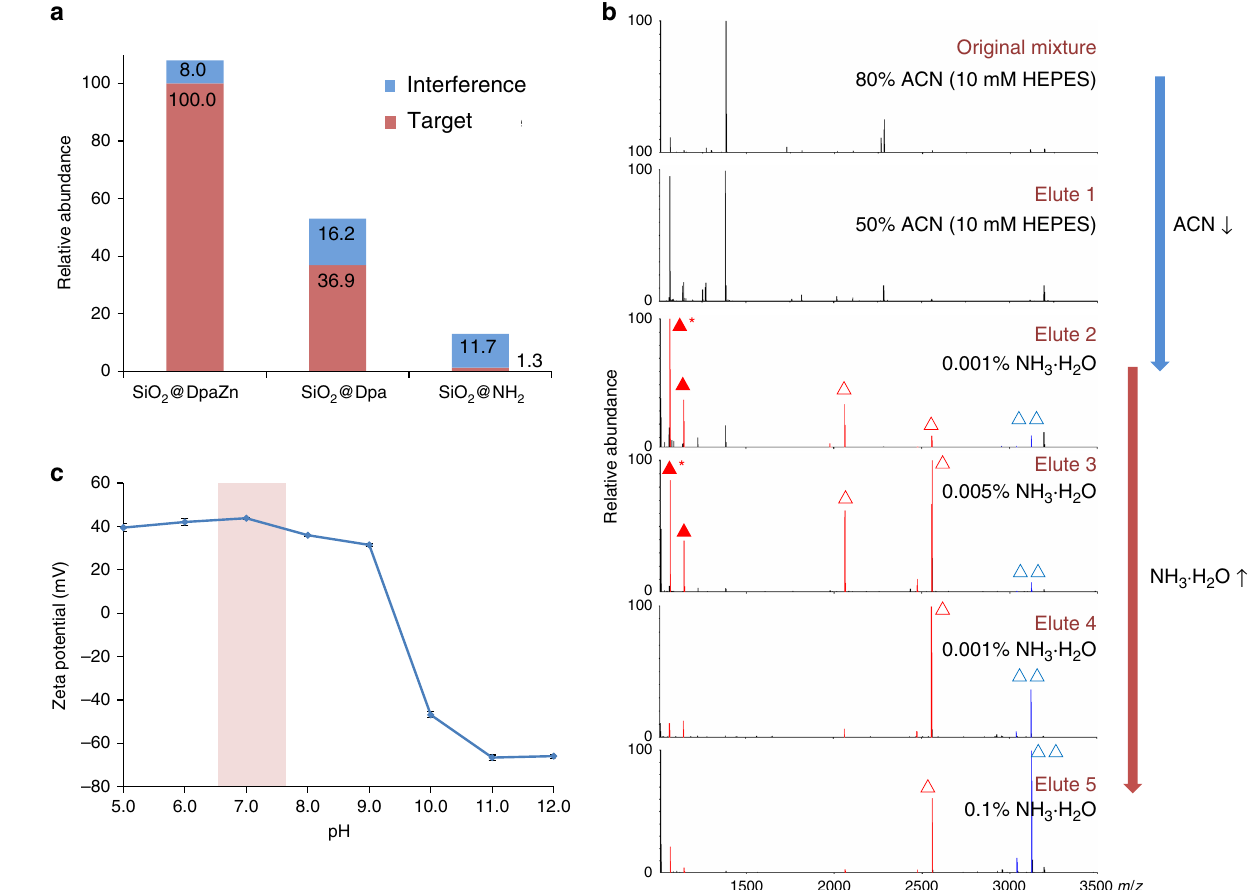
Fig. 6 Investigation on interaction between SiO 2 @DpaZn with phosphopeptides. a Enrichment ability of SiO 2 @DpaZn, SiO 2 @Dpa, and SiO 2 @NH 2 . b Gradient elution of nonphosphopeptides, mono-phosphopeptides (triangle), and multi-phosphopeptides (double triangles). Solid triangle indicates N-phosphopeptide (TS p HYSIMAR), and asterisk-labeled solid triangle indicates the dephosphorylated counterpart (TSHYSIMAR). c Zeta potential of SiO 2 @DpaZn in pH 5.0 – 12.0. Each value represents the mean value from n = 3 parallel experiments. The error bar is represented by SD.